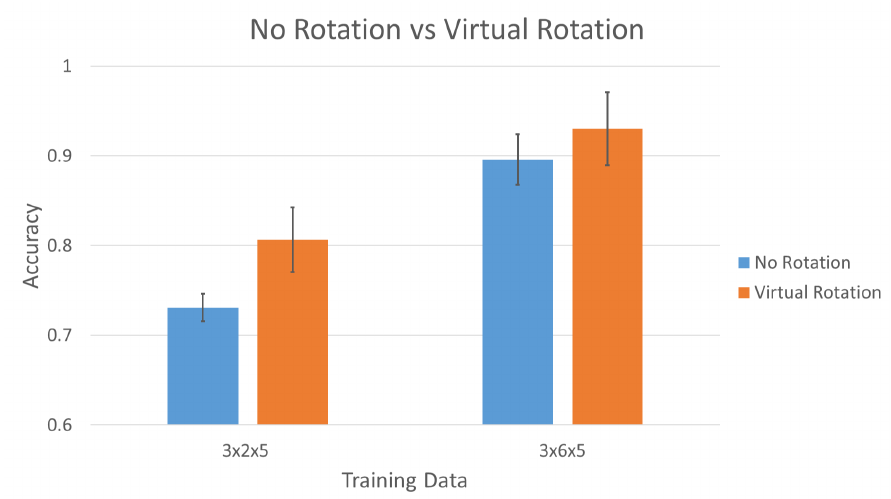
Figure 11. Different training scenarios with different testing